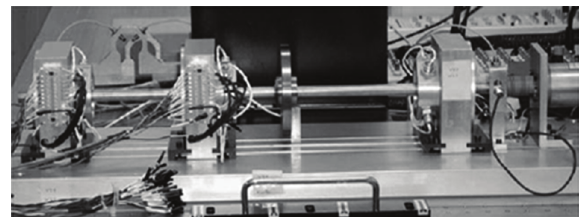
Figure 1: Experimental setup for crack detection in a rotor with active magnetic